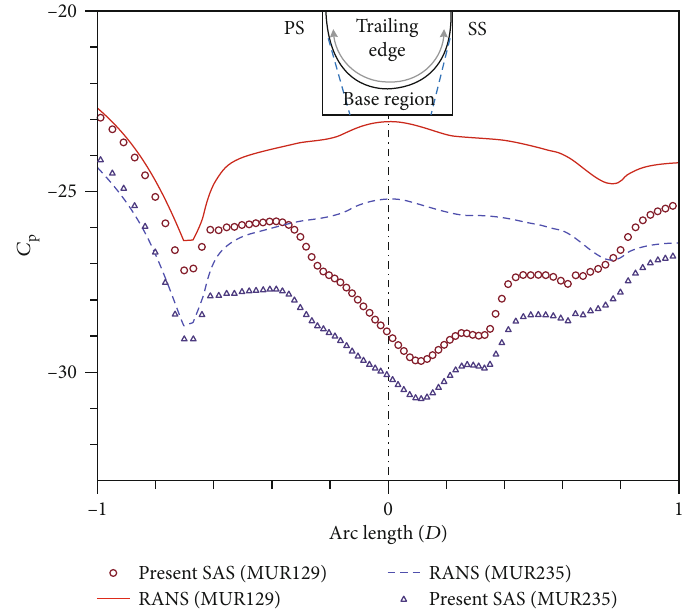
Figure 14: Comparison of base pressure coe ffi cient distribution.